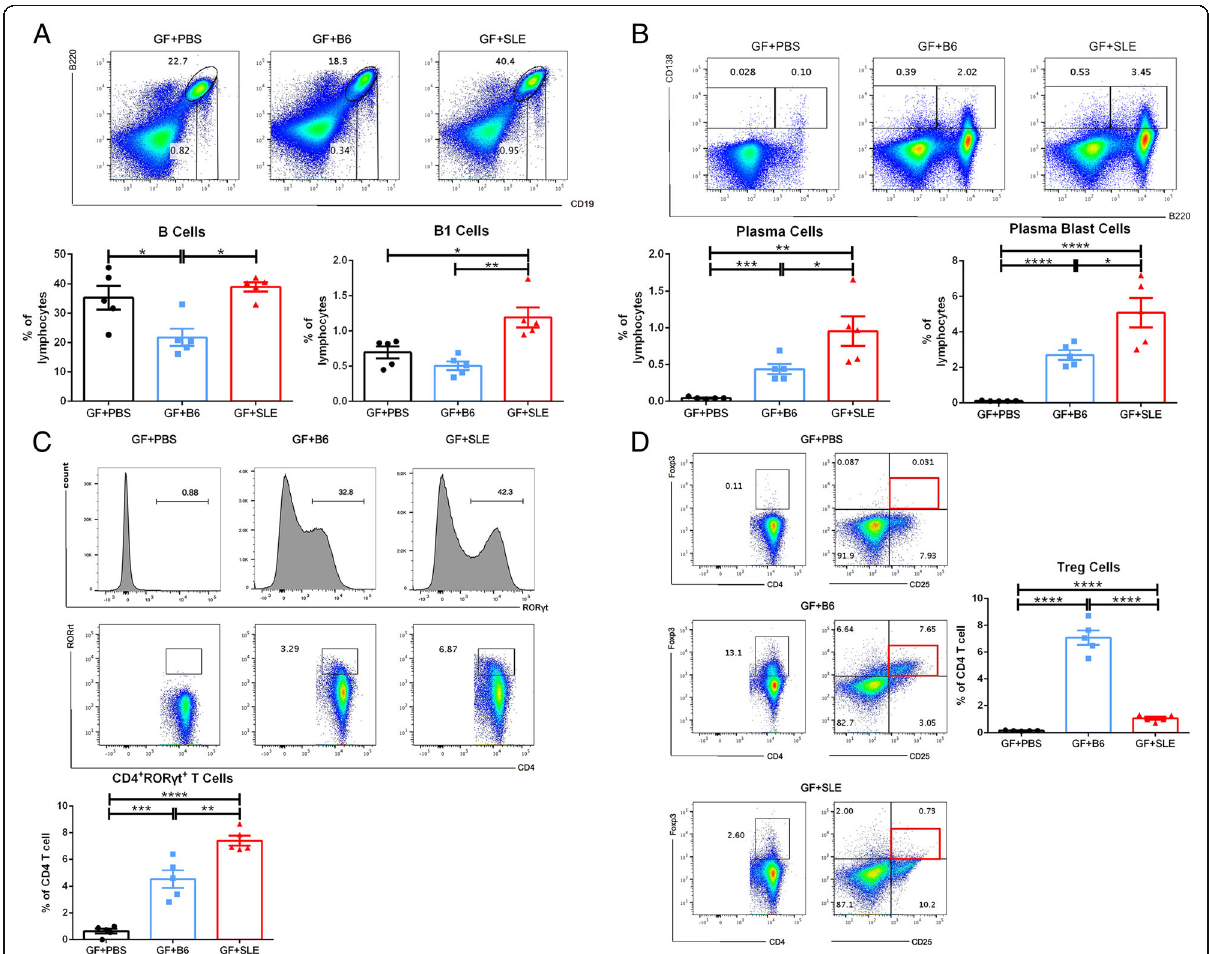
Fig. 4 Flow cytometry analysis of the distribution of lymphocytes in the spleens of GF + PBS mice, GF + B6 mice and GF + SLE mice. (A) Plots of B cells and B1 cells (top) and percentages of B cells and B1 cells (5 mice per group, bottom). (B) Plots of plasma cells (PCs) and plasma blast cells (PBs; top) and percentages of PCs and PBs (5 mice per group; bottom). (C) Histograms of ROR γ t + cells to identify the gate strategy. The number inside the histogram is the percentage of ROR γ t + cells as of live cells (top); Plots of CD4 + ROR γ t + T cells gated on CD3e + CD4 + T cells (middle); and percentages of CD4 + RORrt + T cells (5 mice per group). (D) Plots regulatory T cells (Tregs, left) and percentages of Tregs in 3 groups (5 mice per group; right). Data represent one of three independent experiments. A Mann-Whitney t -test was used to compare groups, and error bars represent means ± SEMs. * P < 0.05, ** P < 0.01, *** P < 0.001, **** P <